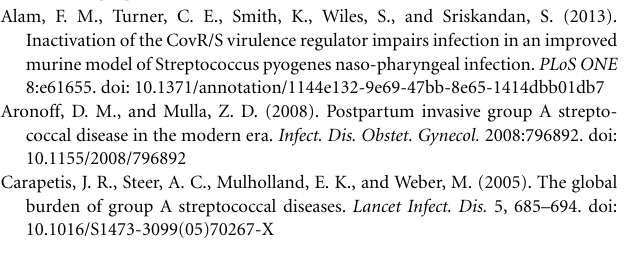
Figure S1 | Expression and activity of SpyCEP ∗ . (A) FACS analysis of anti-SpyCEP antiserum binding to various GAS strains’ surface. (B) Quantification of SpyCEP activity in the supernatants of the various GAS strains by assessment of IL-8 degradation both via ELISA (top panel) and Western blot (bottom panel). Error bars represent standard deviation, statistical analysis was carried out using a two-tailed t -test (ns = p > 0 . 05 ∗∗ Figure S2 | Assessment of cell-surface host proteins by ELISA. (A) Surface expression of the adhesion molecules ICAM and VCAM and of the endothelial cells integrity markers CD144 and trombomodulin (TM) on EA.hy926 cells after exposure to buffer only (control), rSpyCEP (10 μ g/ml) or an unrelated protein (S1LG, 10 μ g/ml) purified using the same method. The graph represents two pooled experiments and error bars represent the standard deviation. Figure S3 | Scanning electron microscopy of GAS WT (A) and GAS (cid:2) cepA (B). Mid-log phase bacterial culture was fixed on cover glass. Each strain observed with FE-SEM displayed the surface structure and both of them had similar surface quality. Scale bar represents